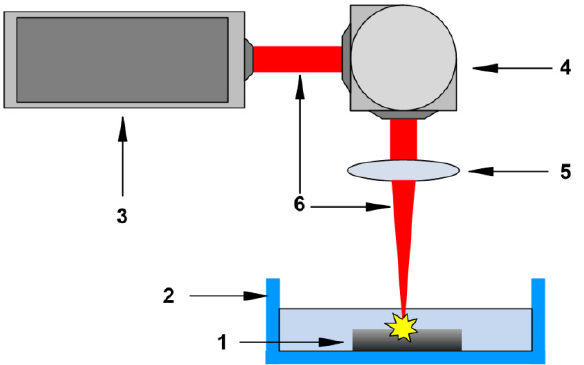
Figure 1. Schematic diagram of a laser ablation setup. 1—Colloid of Ag 2 O Nps in water; 2—Cuvette in a water-cooled cell; 3—Nd: YAG laser; 4—Galvano-mirror system; 5—F-theta objective; and 6—laser beam.